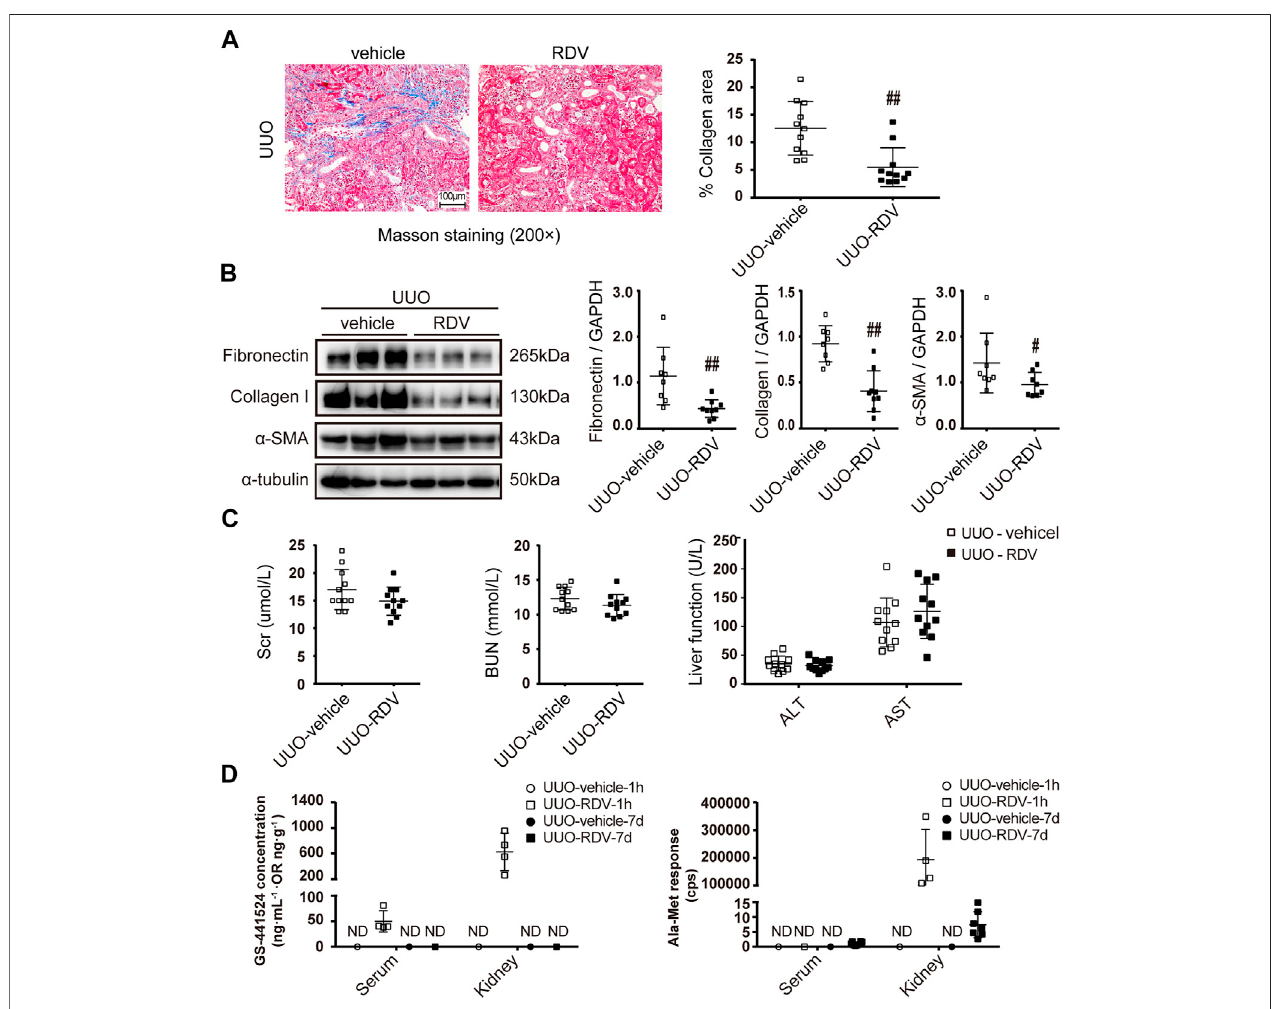
FIGURE 3 | Intrarenal administration of RDV inhibited fi brosis in UUO mice. 50 μ L of vehicle or RDV (1 mg/ml) was injected intrarenally to the left kidney, which was subjected to the UUO operation thereafter. Serum and renal tissues were collected at 1 h or day 7 after UUO operation (A) Renal fi brosis was assessed by Masson ’ s trichrome staining, and then was quanti fi ed (B) The expression of FN, collagen I (Col-1) and α -SMA were measured by Western blotting. One representative of at least three independent experiments is shown (C) Liver function (ALT and AST) and renal function (Scr and BUN) were assessed (D) The concentrations of nucleoside metabolite (GS) and alanine metabolite (Ala-Met), two RDV metabolites, in serum and kidneys were determined by LC-MS/MS. Data represent mean ± SD. ND represents not determined. # p < 0.05 vs. UUO-vehicle; ## p < 0.01 vs. UUO-vehicle.